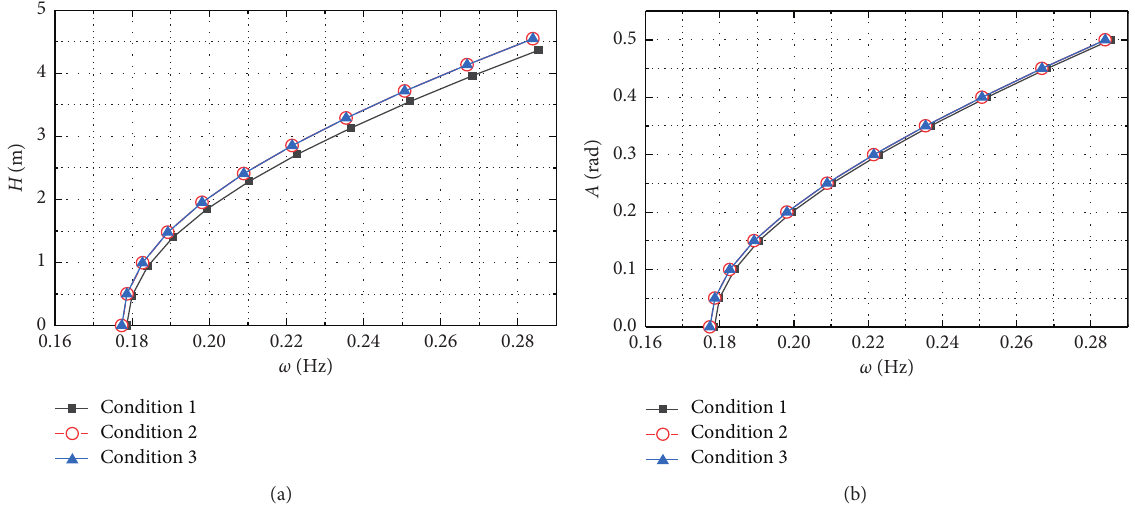
Figure 12: Curves of frequency and amplitudes of LCOs in three conditions. (a) ω vs. H . (b) ω vs. A .